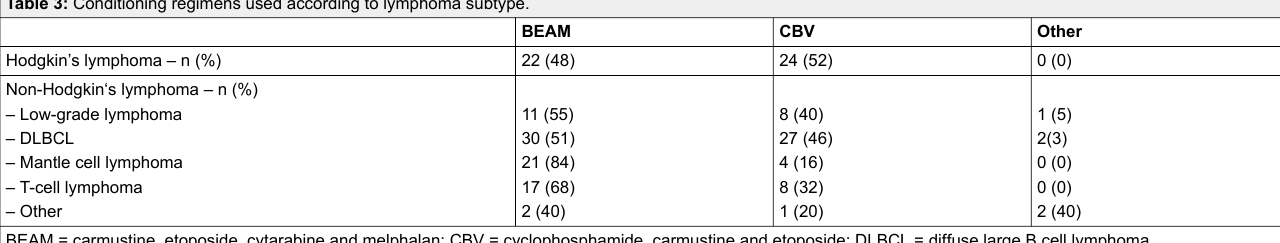
Table 3: Conditioning regimens used according to lymphoma subtype.